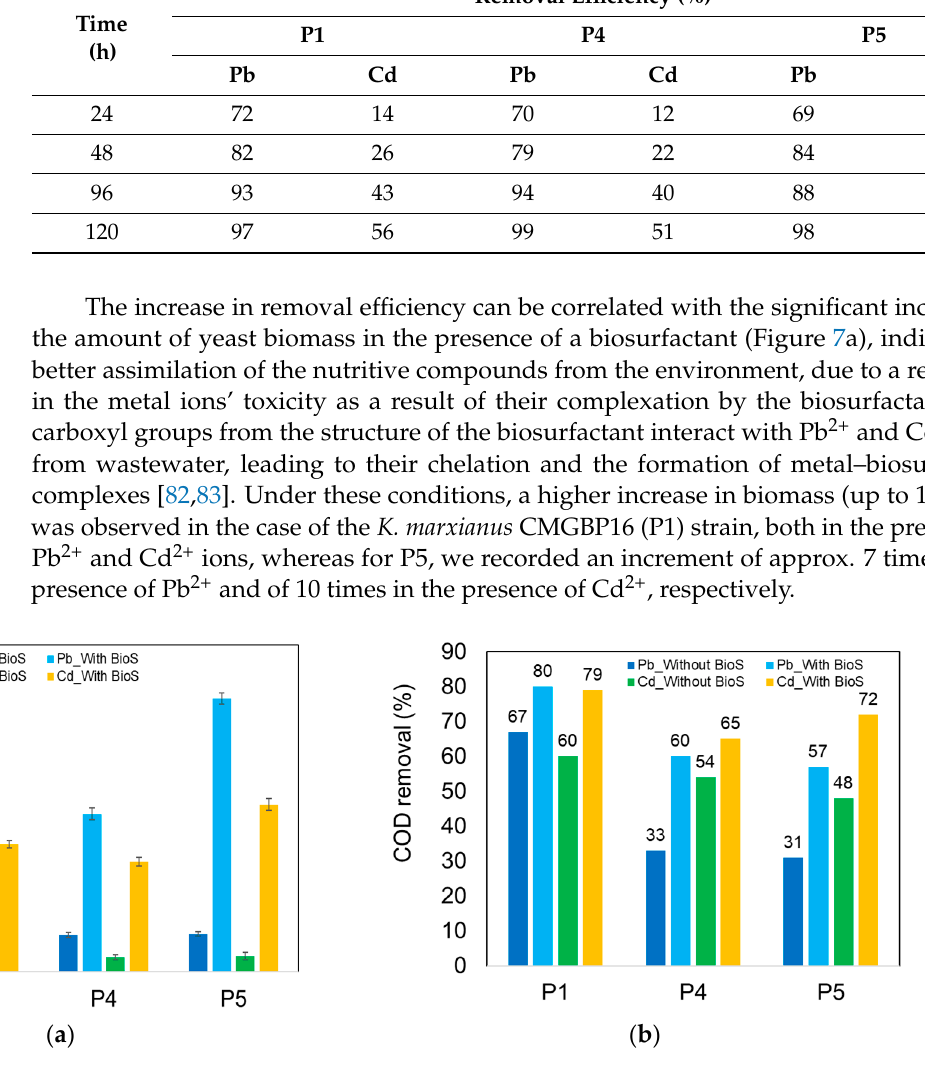
Table 4. Pb and Cd ions’ removal efficiency with biosurfactant.